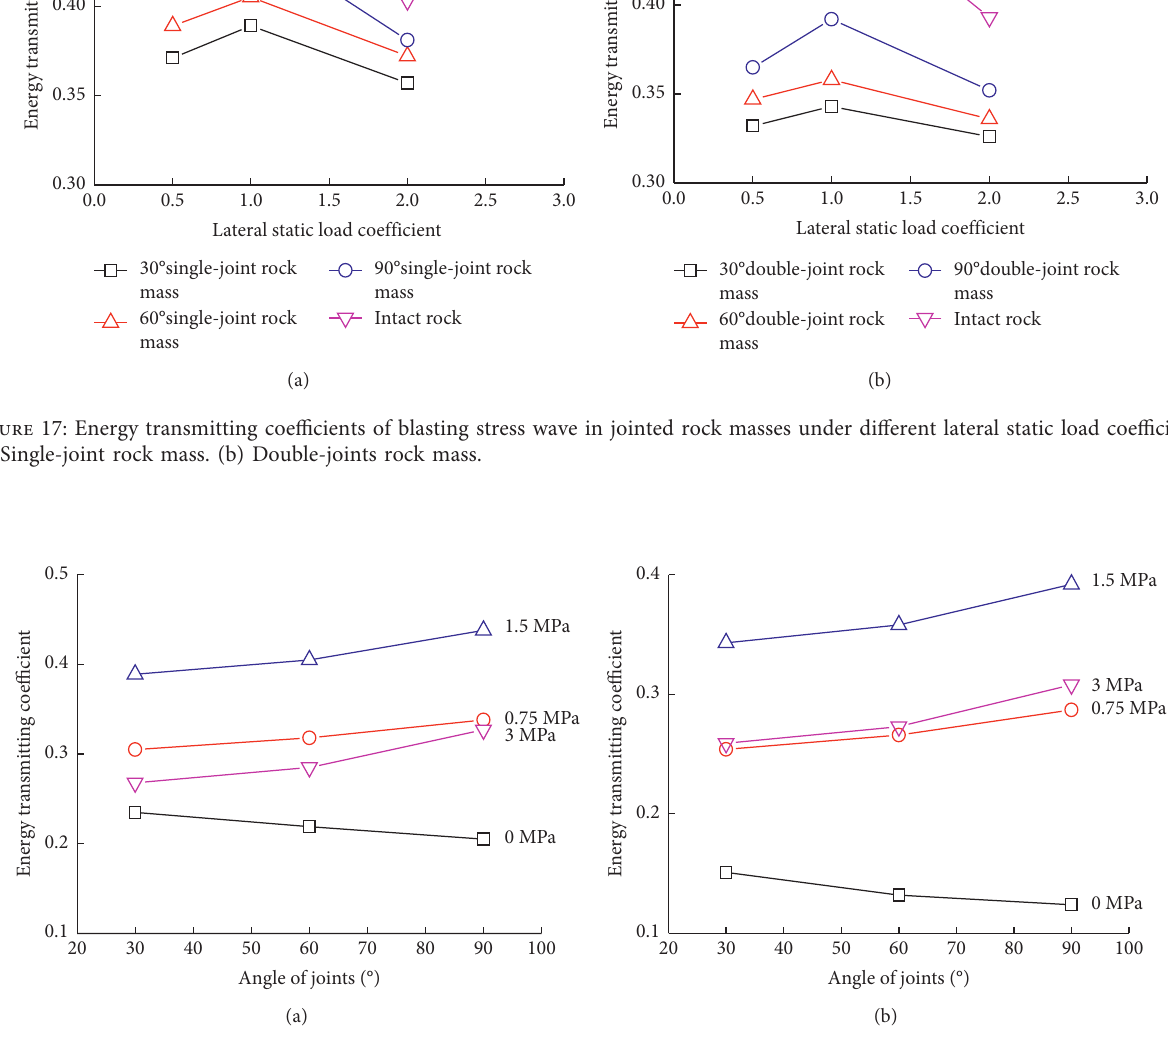
Figure 18: Influence of joint angle on energy transmitting coefficient of stress wave under equal biaxial static loads. (a) Single-joint rock mass.. (b) Double-joints rock